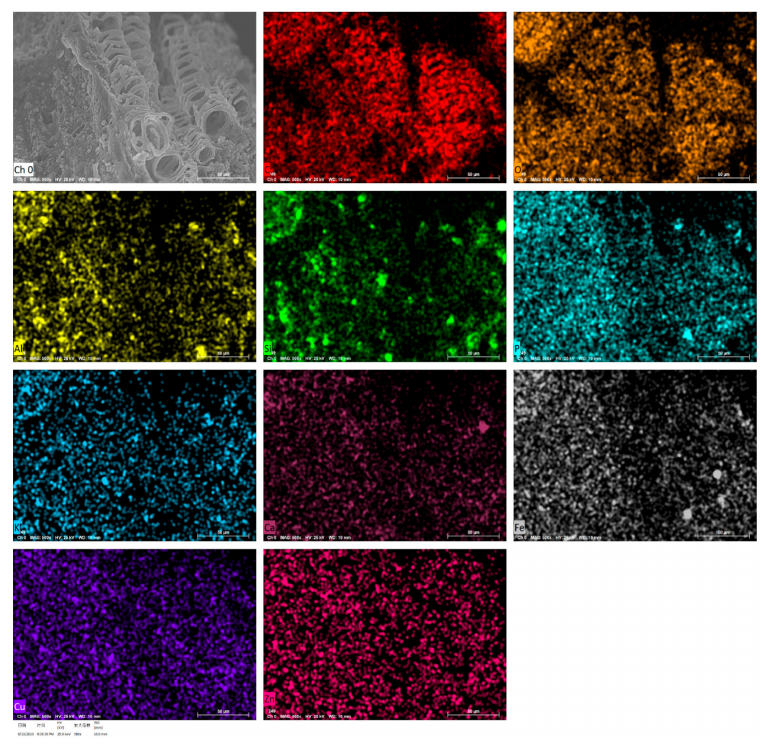
Figure 10. SEM image and the corresponding EDS mapping of BR after adsorption Cu.